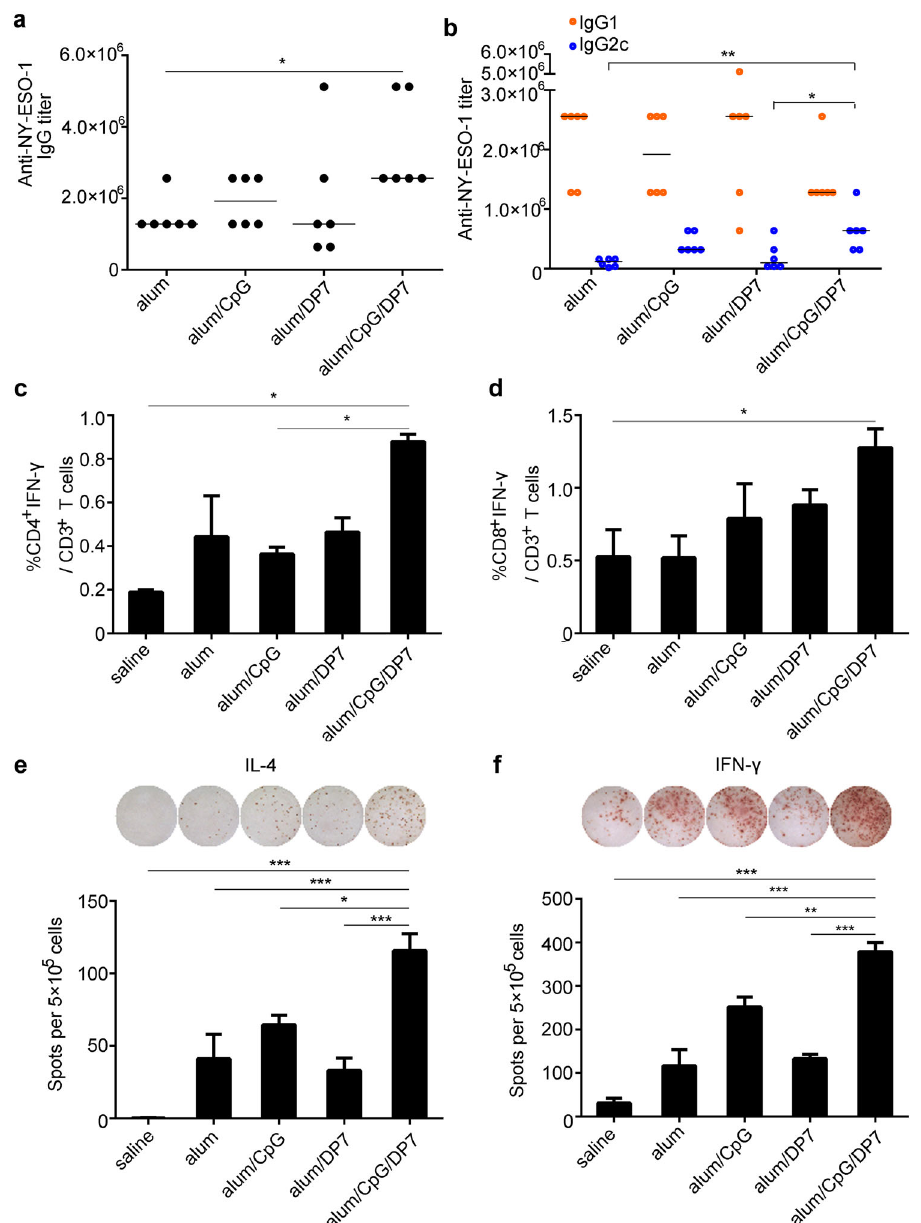
Fig. 4 Enhancement of humoral immunity and the Th1/Th2 balance were induced by alum/CpG/DP7-based vaccines. a , b Mice ( N = 6/ group) were immunized with NY-ESO-1 plus various adjuvants on days 0, 14, and 28. The levels of IgG ( a ), IgG1 and IgG2c ( b ) speci fi c for NY- ESO-1 were detected by ELISA one week after the third immunization. Bars represent median. c , d The frequencies of IFN- γ -secreting CD4 + and CD8 + T cells were examined by intracellular IFN- γ staining ( N = 3/group). e , f The average number of IL-4/IFN- γ -secreting splenocytes was calculated ( N = 3/group). Bars represent means and SEM. * P < 0.05, ** P < 0.01, *** P <